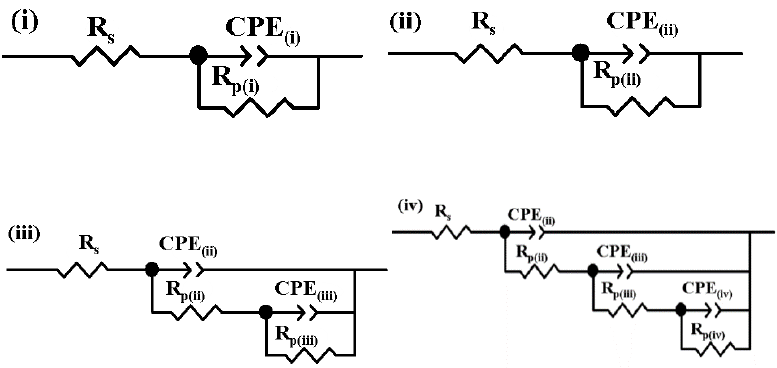
Figure 6. Equivalent circuits used to simulate and model the resulted data of the electrochemical impedance spectroscopy (EIS) spectrum obtained in seawater for ( i ) unprotected EH36 steel; ( ii ) EH36 welded joint without coating; ( iii ) EH36 welded joint coated with epoxy primer; ( iv ) EH36 welded joint covered with polymeric primer with dispersed TiO 2 nanoparticles.